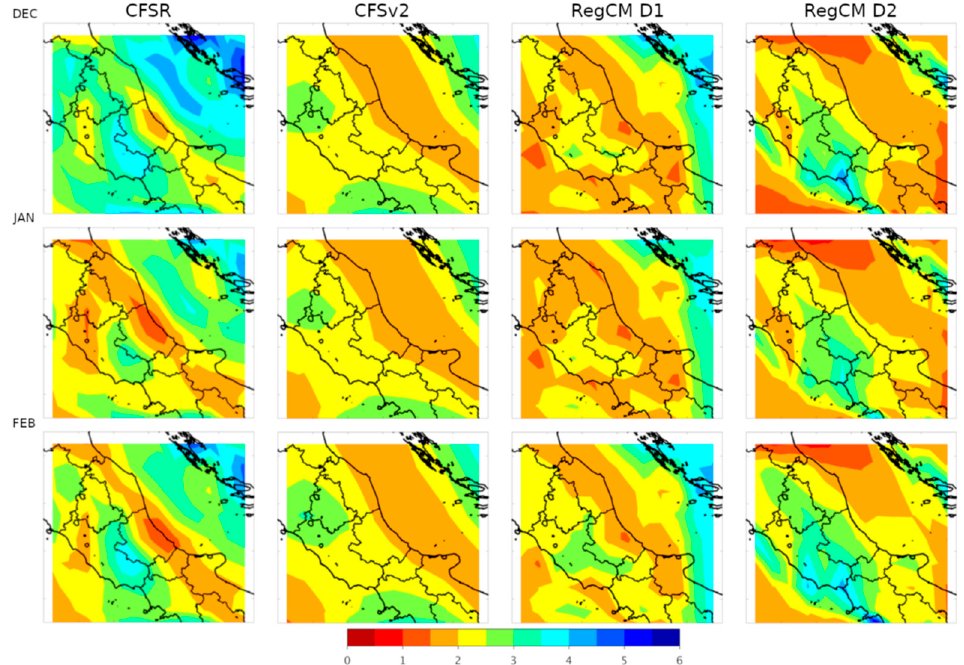
Figure 8. Spatial distribution of daily mean precipitation for the winter climatological period for: reanalysis, CFSv2, RegCM-d1, and RegCM-d2 (columns from left to right).